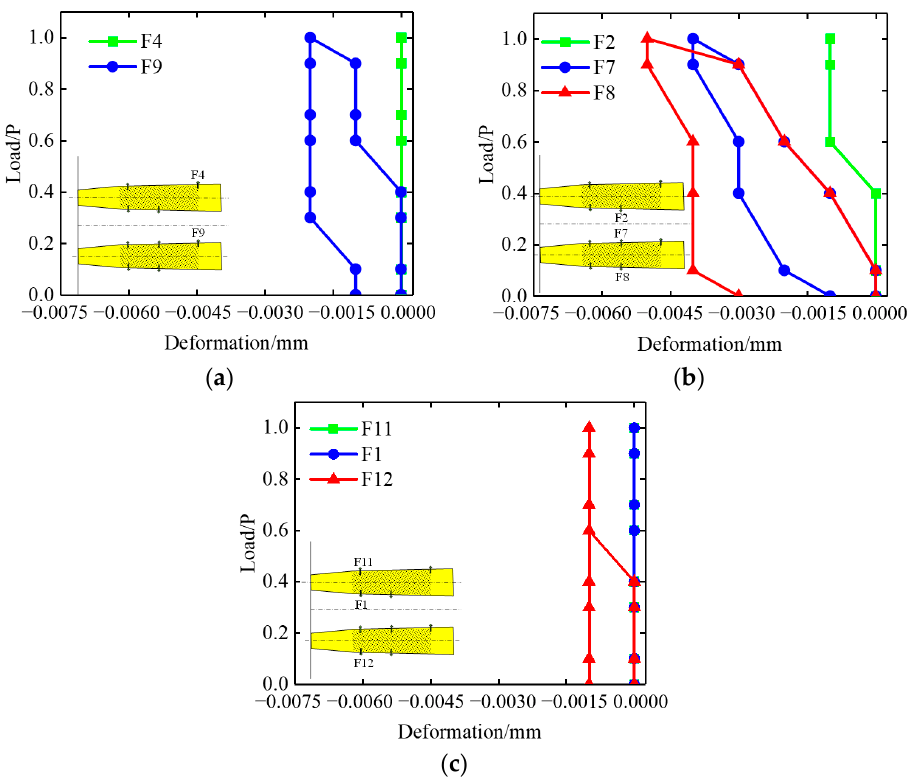
Figure 7. Test results of dislocation meter deformation experiment: ( a ) back anchor surface; ( b ) middle anchor; ( c ) front anchor.